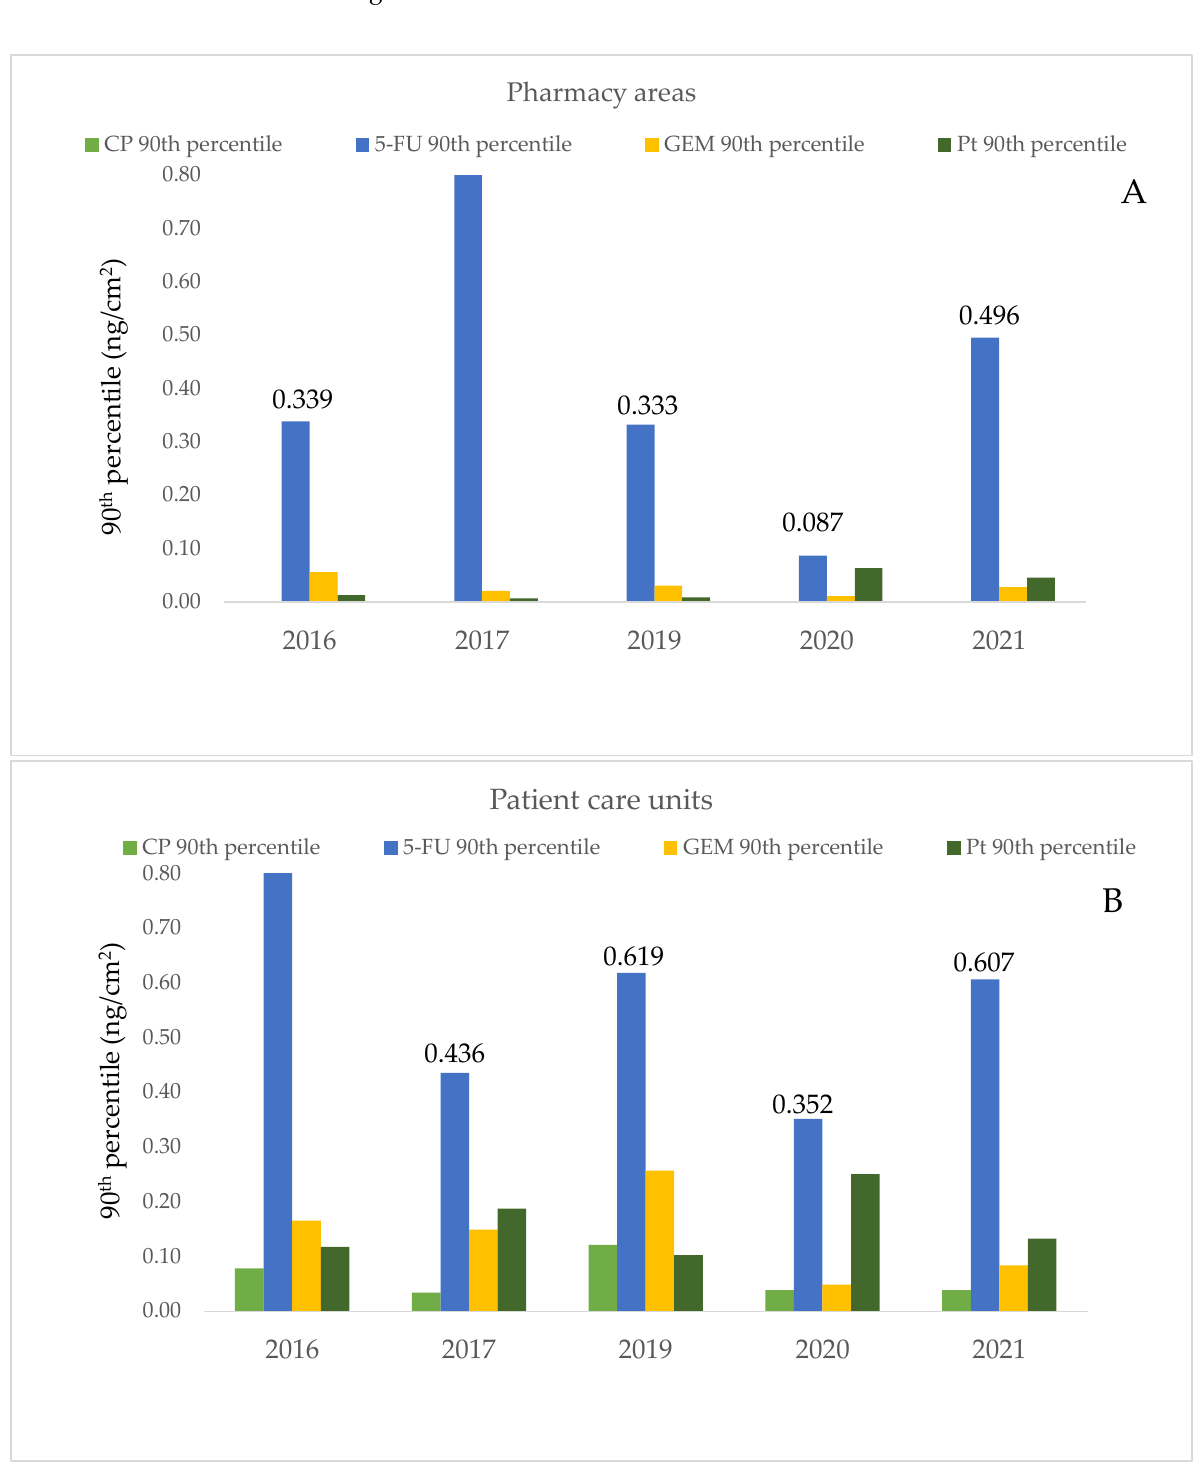
Figure 2. Trends of contamination in pharmacy areas ( A ) and patient care units ( B ) based on the 90th percentile of data distribution for each drug (CP=cyclophosphamide, 5-FU = 5-fluorouracil, GEM = gemcitabine, Pt = platinum compounds) and over a 5-year monitoring